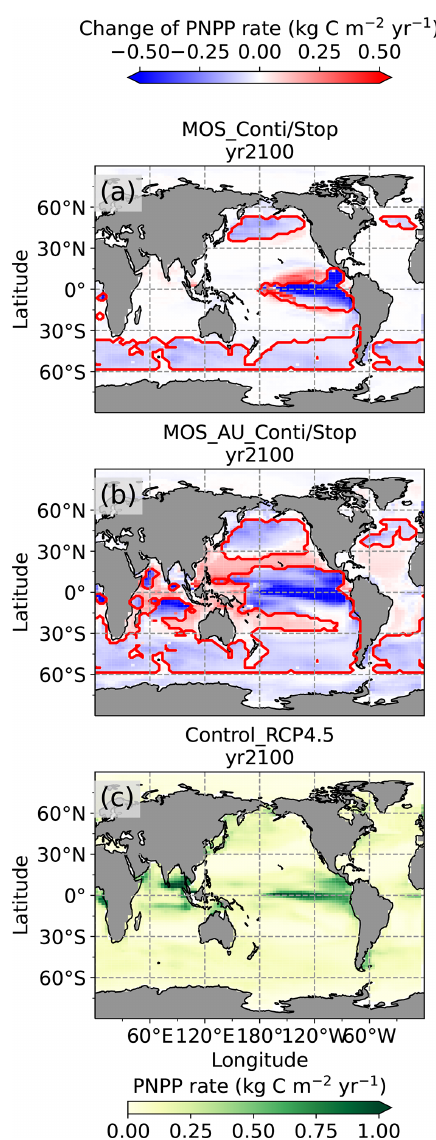
Figure 7. Vertically integrated annual PNPP in year 2100. (a, b) MOS minus Control_RCP 4.5, with red boundaries contouring the MOS-occupied area; (c) Control_RCP 4.5; (a) illustrates a de- cline in PNPP in MOS-occupied areas accompanied by a “halo” of enhanced PNPP surrounding MOS areas, particularly in the ETP caused by the leakage of residual nutrients (Sect. 4.3.4). These im- pacts on PNPP are amplified in MOS_AU (b)